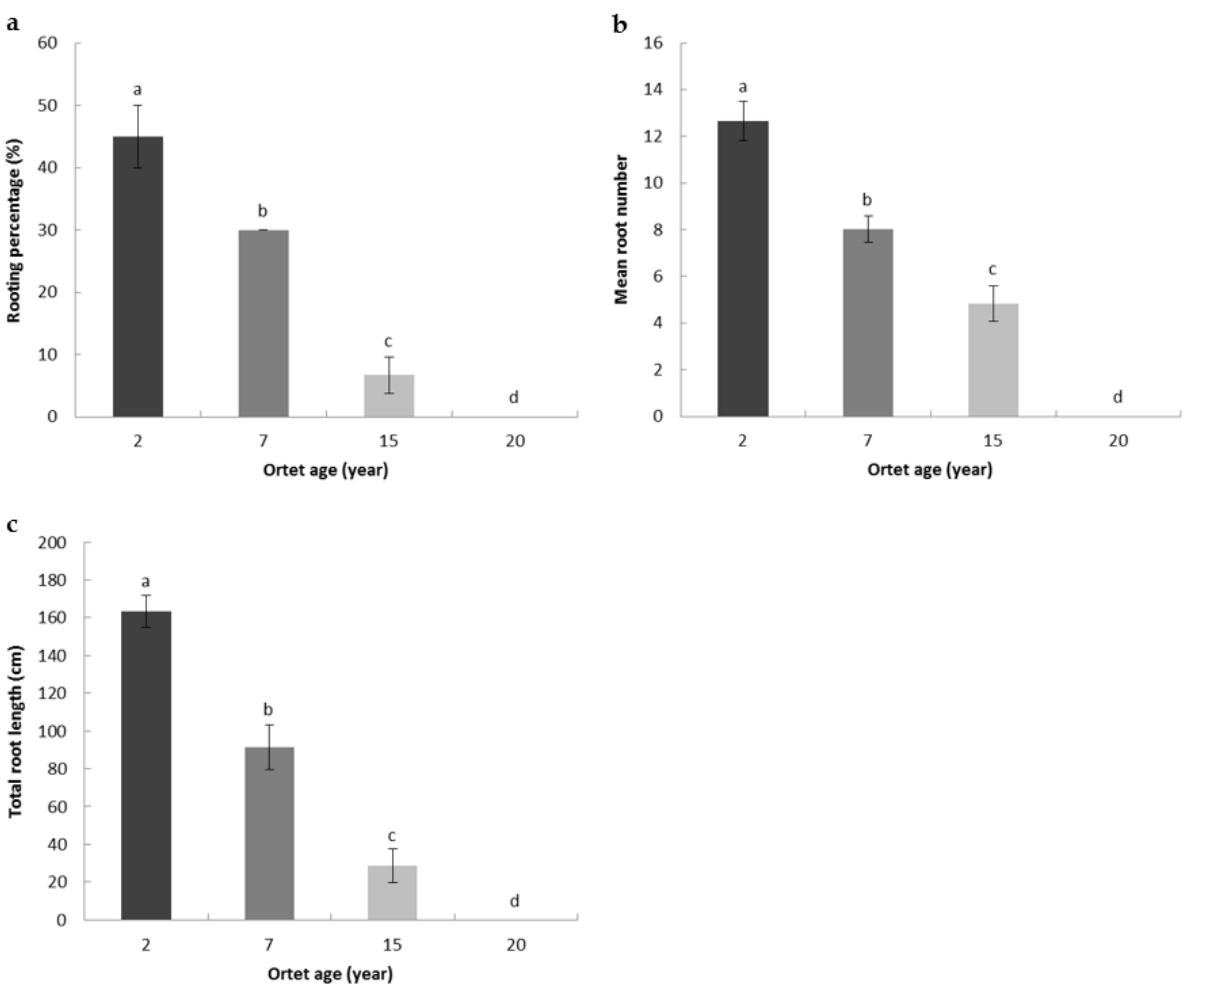
Figure 1 . Multiple comparisons of different ortet ages with respect to adventitious rooting. ( a ) Rooting percentage; ( b ) mean root number; ( c ) total root length. Different lower-case letters indicate significantly differences under 0.05 levels.